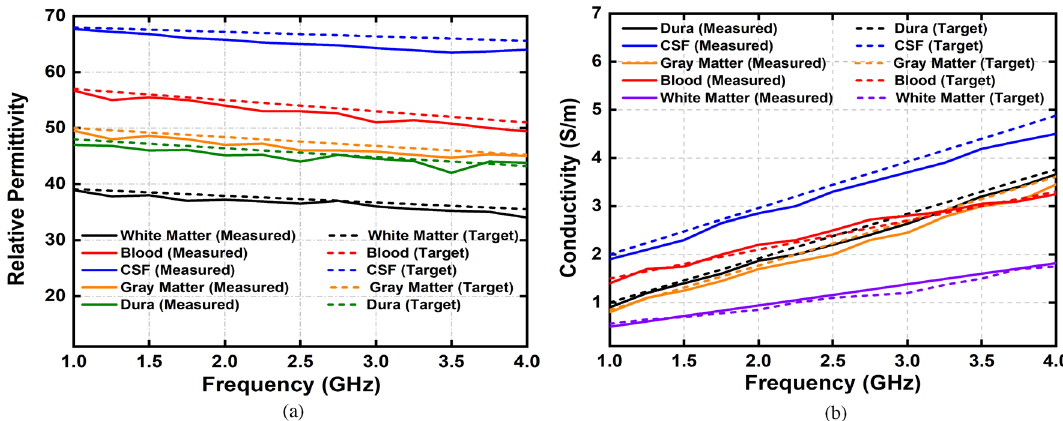
Figure 20. Actual and measured values of human head phantom ( a ) relative permittivity and ( b )